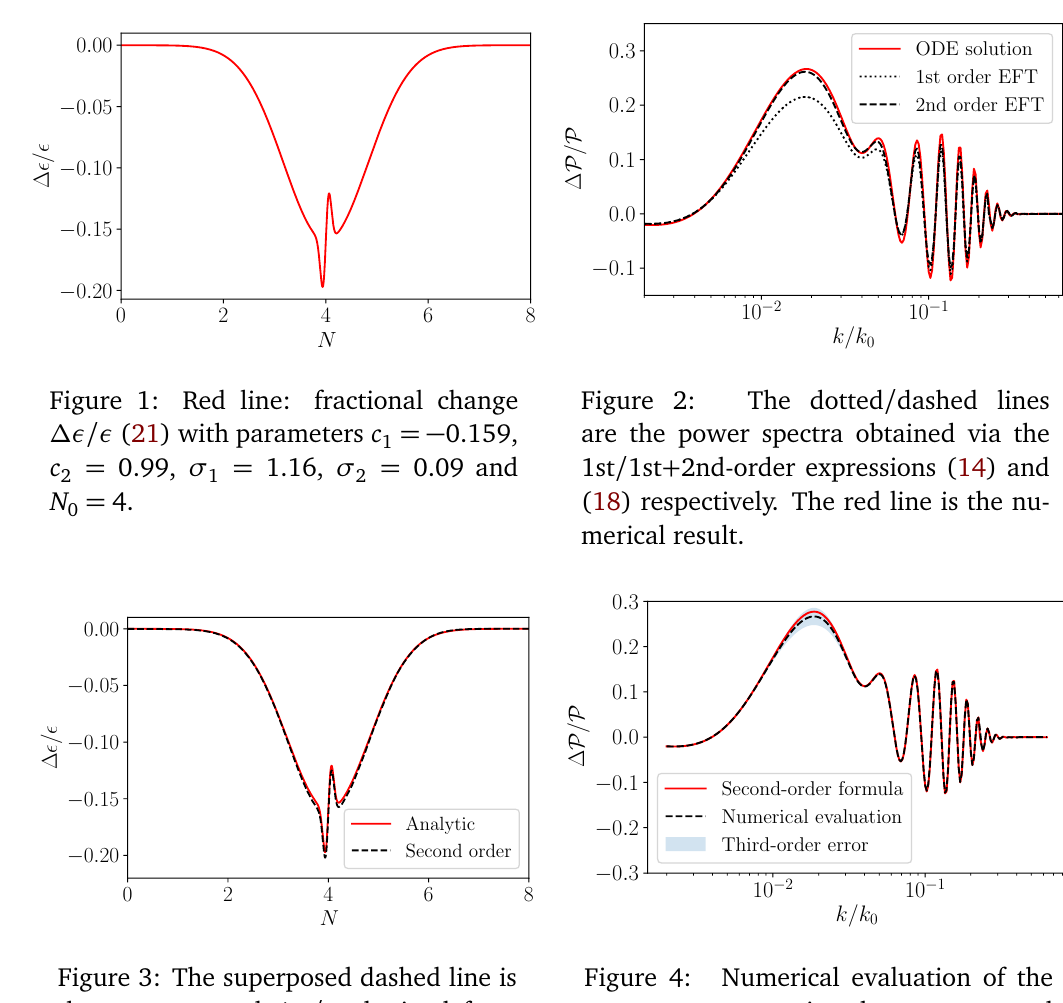
Figure 3: The superposed dashed line is the reconstructed ∆ ε/ε obtained from evaluating (15) using the exact power spectrum in (19).